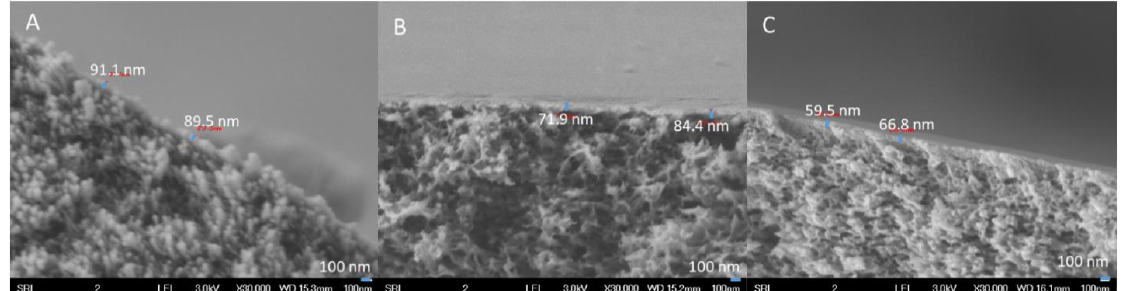
Figure 5. Typical morphology of polybenzimidazole hollow-fiber (PBI HF) (air gap = 2.5”).